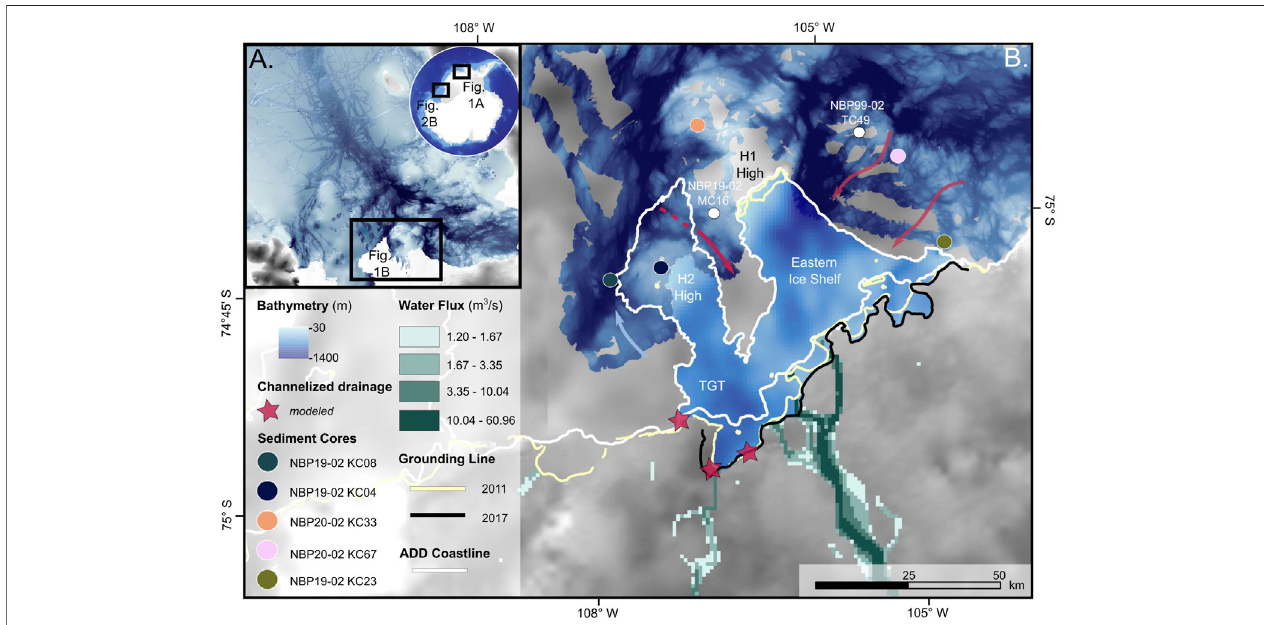
FIGURE 1 | Regional map and locations of sediment cores used in this study. Bathymetry of the eastern Amundsen Sea Embayment (A) and in the vicinity of ThwaitesGlacier (B) .Datain Figure1B wereprimarilycollectedoncruisesNBP19-02(Hoganetal.,2020)andNBP20-02andaregriddedat50 m.Bathymetryde fi ning muchoftheeasternmarginoftheEasternIceShelfwascollectedduringtheiStarprojectcruiseJR294.AdditionalbathymetryandbedtopographyarefromBedMachine (Morlighemetal.,2020),andsub-iceshelfbathymetryisfromJordanetal.(2020).Redandbluearrowsdenotein fl owofwarmwaterandout fl owofmeltwater-laden fresher water, respectively, from Wåhlin et al. (2021). Grounding-line data are from Rignot et al. (2011) and Milillo et al. (2019) and coastline data are from the Antarctic Digital Database (ADD). Subglacial fl ux is from the Quantarctica data package and was derived from a subglacial water routing algorithm run at a 1-km resolution, originally published by Le Brocq et al. (2013). Stars approximate where modeled subglacial channels coincide with the Thwaites Glacier grounding zone (Hager et al., 2021).